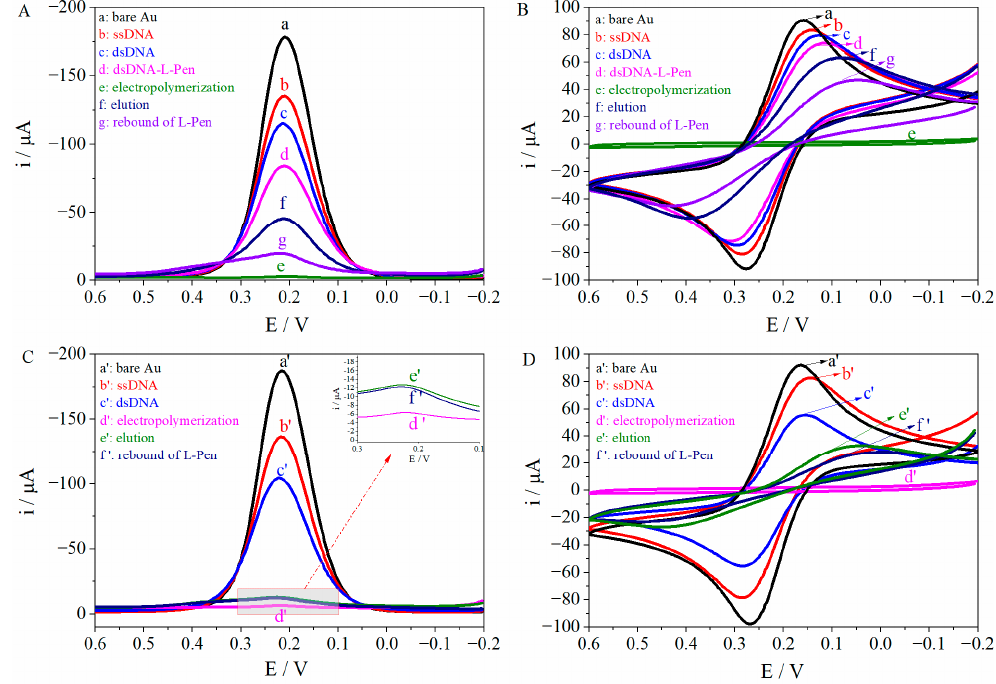
Figure 1. The DPV ( A ) and CV ( B ) responses of MIPs/dsDNA under different conditions and the DPV ( C ) and CV ( D ) of non-MIPs/dsDNA under different conditions (working potential: − 0.2~0.6 V; scan rate: 50 mV/s; pulse amplitude: 50 mV).